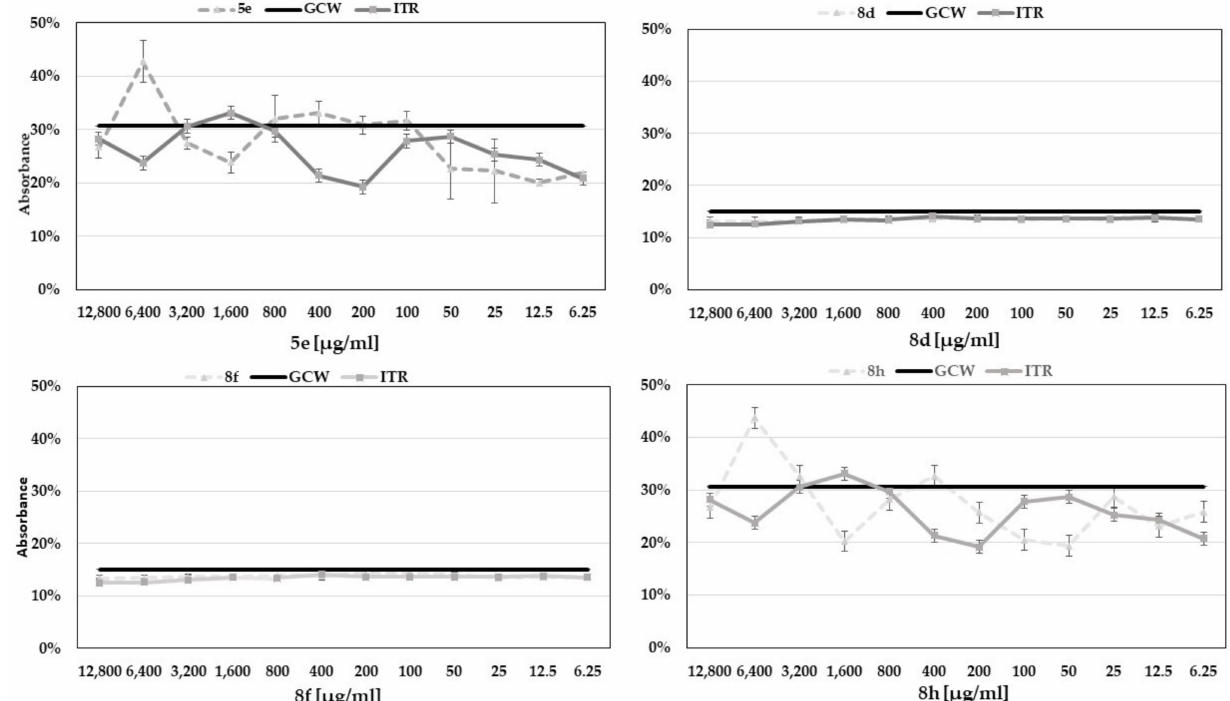
Figure 3. The interaction between benzoxazoles and exogenous ergosterols. Legend: Absorbance at 400nm after 96 h incubation of the C. albicans SC5314 cells in YEPD containing different concentrations of benzoxazoles and exogenous ergosterol. The mean % of absorbance of the growth control is presented as GCW. ITR means Itraconazole. The assay was performed in triplicate. Values are presented as means ± SD.